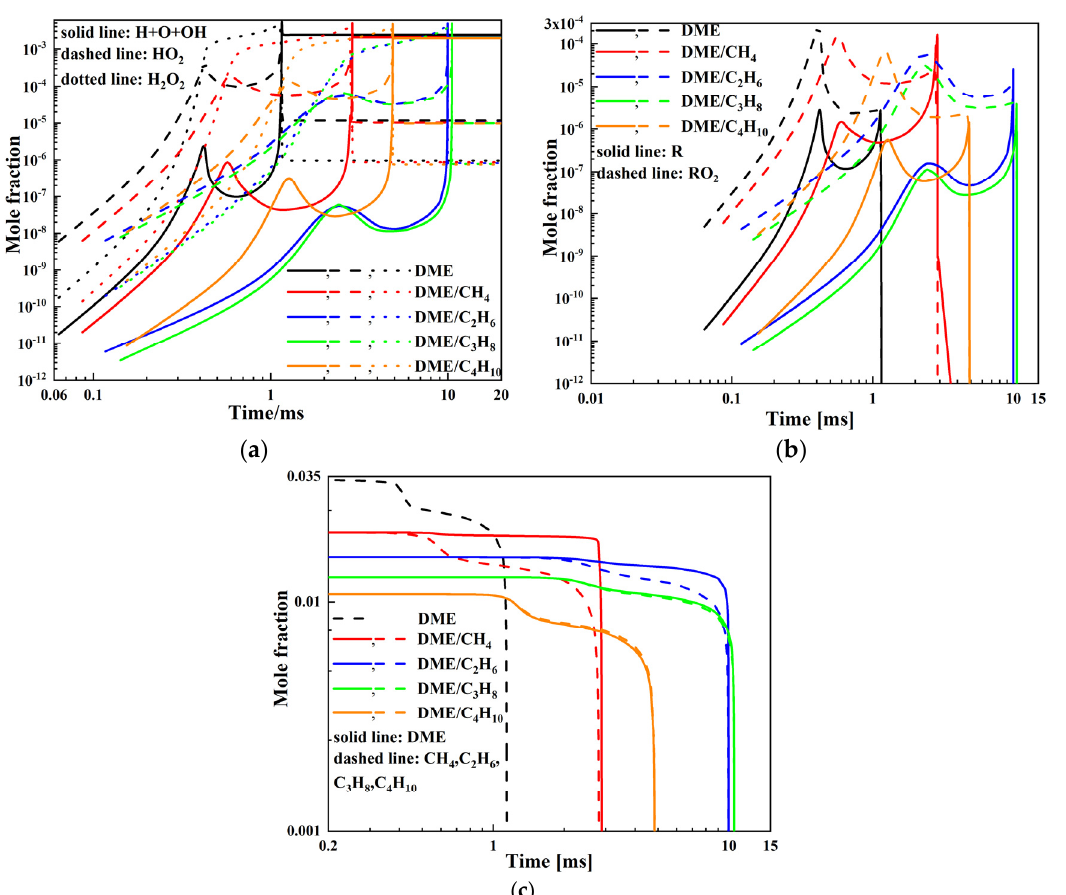
Figure 5. Mole fraction of various species for DME/C1-C4 alkane mixtures at T c = 650 K, P c = 20 bar, and φ = 0.5: ( a ) H, O, OH, HO 2 and ( b ) R, RO 2 .